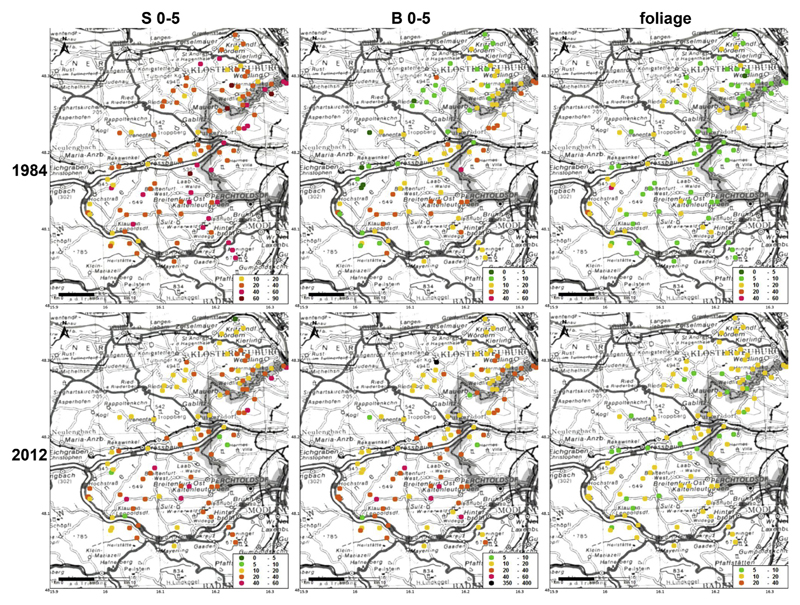
Geographical distribution of top soil Cu contents in the infiltration zone of stemflow (S 0–5; left) and the between trees area (B 0–5; middle), as well as foliar Cu contents (right), sorted by classes (mg kg−1), in beech stands of the Vienna Woods in 1984 (top) and 2012 (bottom).